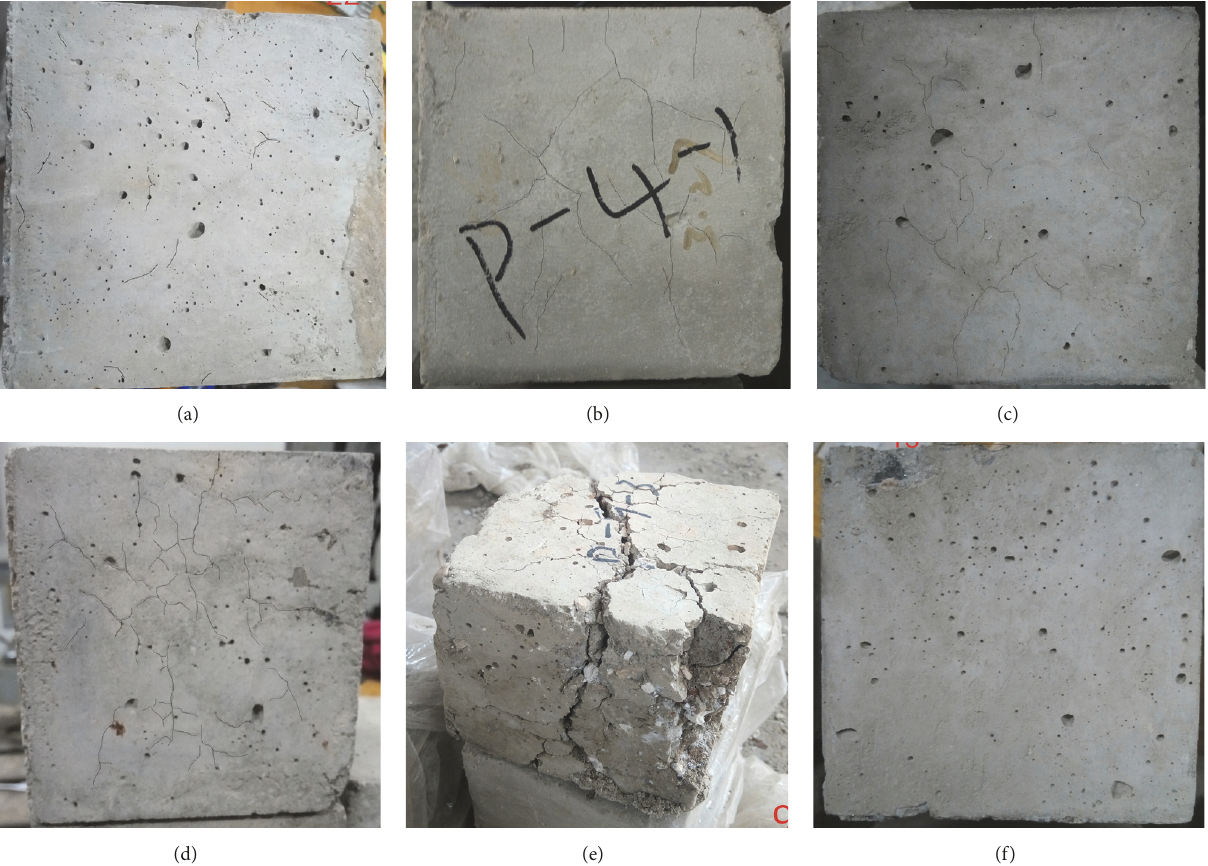
Figure 2: The apparent changes of HSC after different high temperature processes: (a) P-2-2; (b) P-4-1; (c) P-4-3; (d) P-6-0.5; (e) P-8-3; (f) normal temperature (P-X-X indicates fatigue test, heating temperature ( × 100 ∘ C), holding time (h), such as P-2-2 indicates holding 2 h after heating up to 200 ∘ C).